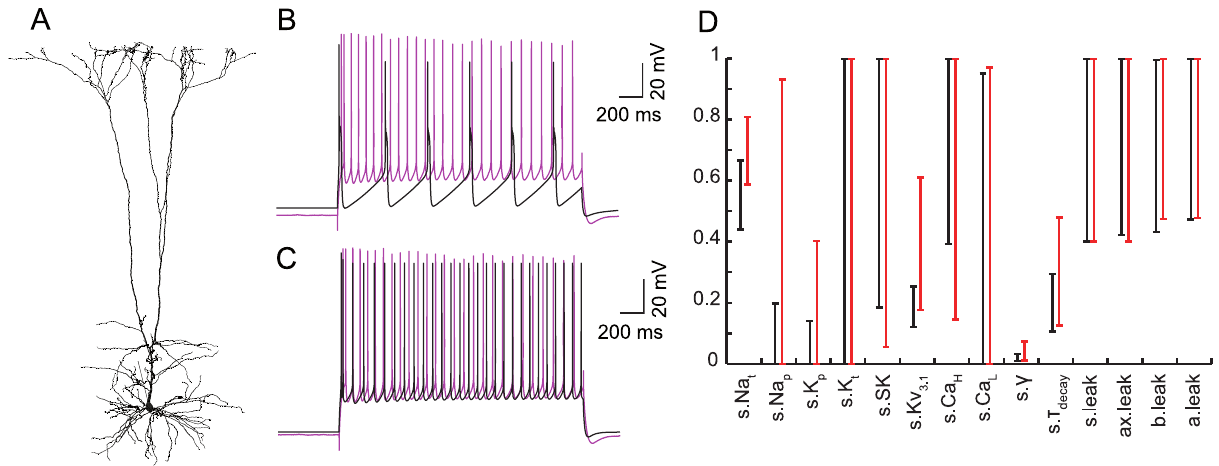
Figure 7. Model transfer between largely different morphologies is unsuccessful. A. Reconstruction of a third L5b PC morphology, cell # 3, of the same age as cell # 1 but with very proximal main bifurcation and larger dendritic tree area. B. Using cell # 3 with the parameters of the acceptable model shown in Figure 4 did not yield a proper response even to somatic depolarization. C. Example of an acceptable model for perisomatic step current firing in cell # 3. D. The parameter ranges of models for perisomatic step current firing using the morphology of cell # 1 (black, n=139) or cell # 3 (red, n=77) generally overlap, but not as tightly as for the second, more similar, morphology (Figure 6). Na t and Kv 3.1 ranges are shifted. Real values for the different ion conductances can be derived by referring to the upper limits given in Table 2.